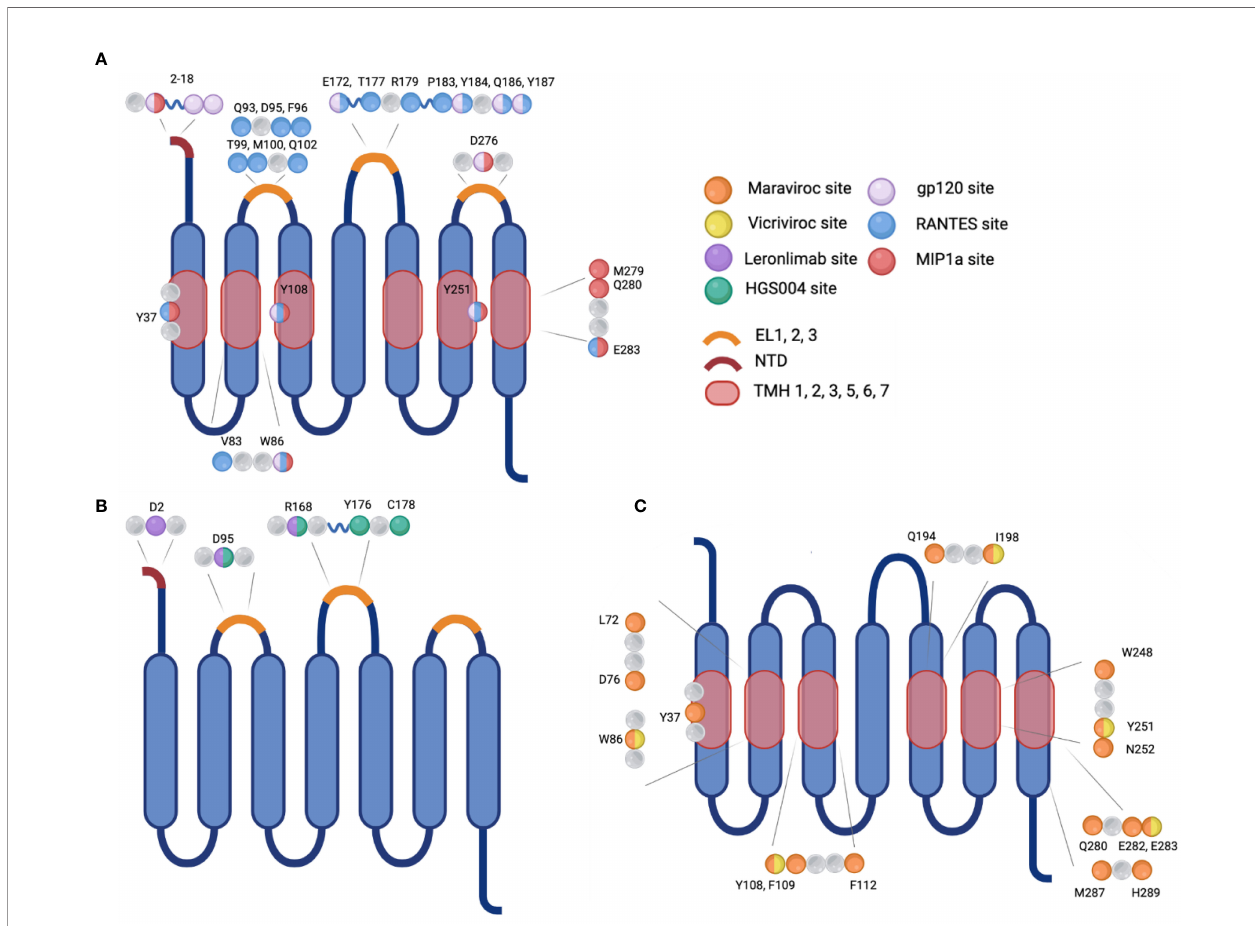
FIGURE 2 | Visualization of the sites of interaction on CCR5 for natural ligands, HIV-1 gp120, monoclonal antibodies, or small molecule inhibitors. (A) Binding sites for the natural ligand RANTES or HIV-1 gp120. (B) Binding sites for monoclonal antibodies Leronlimab or HGS004, and (C) Binding sites for small molecule inhibitors Maraviroc or Vicriviroc. Mutation at selected amino acids inhibit interaction between binding molecule and receptor. EL, extracellular loop; NTD, N-terminal domain; TMH, transmembrane helical